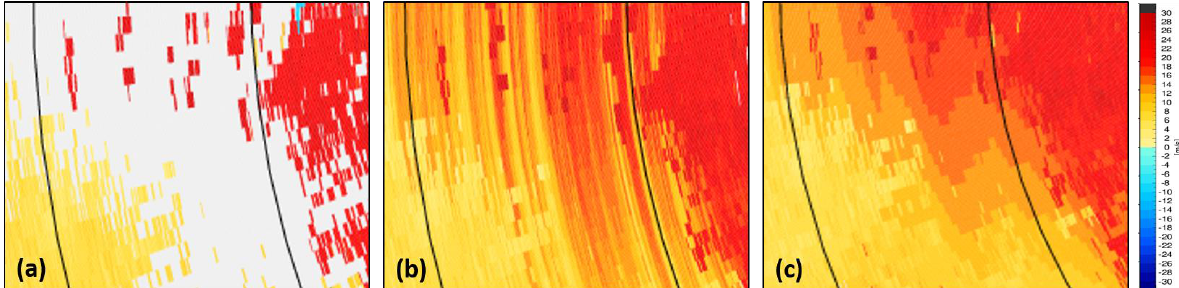
Figure 6. Example of restoring the radial velocity of the KWK radar site at 0400 local standard time (LST) on 24 July 2020. ( a ) Before restoring radial velocity. ( b ) Restoration using each VAD fitting function calculated from all azimuth scans. ( c ) Restoration using a VAD fitting function calculated from the mean of several neighboring azimuth scans. The two black lines indicate range lines at the radius of 150 km and 200 km from the radar, respectively.